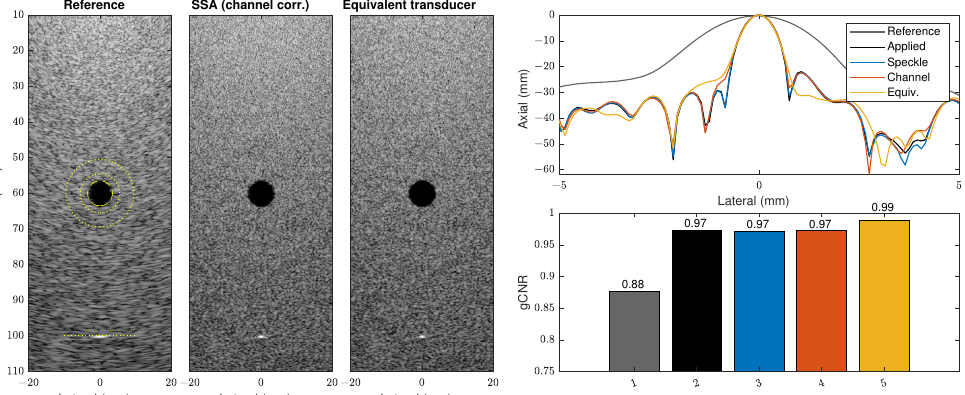
Figure 7. Simulation comparison of reference image, SSA images and equivalent transducer matched to the effective length of the SSA acquisition. ( Left ) Images for reference, channel correlation estimated SSA and equivalent transducer, shown with a 50 dB dynamic range and ROIs indicated for the lesion and point. ( Right top ) Lateral PSF for point at 10 cm depth. ( Right bottom ) gCNR for anechoic lesion target located at 6 cm